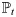
Effect of fluctuating TGF-β on tumor growth.(A) A time-dependent TGF-β level was assigned for a periodic supply of TGF-β in tumor microenvironment. (B) Trajectories of solutions ((G(t), C(t)) and (G(t), I(t))) in response to TGF-β in (A). The thick gray curve represents the upper and lower branches of steady states (C − G hysteresis bifurcation loop in Fig 6). Red and blue arrows = solution flow direction of C and I, respectively. (C) Time courses of concentrations of C and I in response to periodic G input in (A). The N2-dominant Pt-regions were shaded in pink. (D) Time courses of tumor volumes in response to a fixed (G = 0.9 (blue circle); G = 0.1 (dashed)) and fluctuating TGF-β level. Fluctuating TGF-β levels induce transitions between N1- and N2-dominant phenotypes, leading to transient tumor growth at the transition times (t1, t2, t3, t4). (E) The N2-to-N1 ratio and tumor size for three TGF-β conditions in (D). (F) Positive correlations between the tumor volume and the N2-to-N1 ratio with two initial conditions (C(0) = 1, I(0) = 2.5 in red asterisk; C(0) = 2.5, I(0) = 1 in blue circle). Initial conditions in (A-E): C(0) = 0.4, I(0) = 3.6, G(0) = 0.2, T(0) = 0.2. Other parameters are given in Table 2.